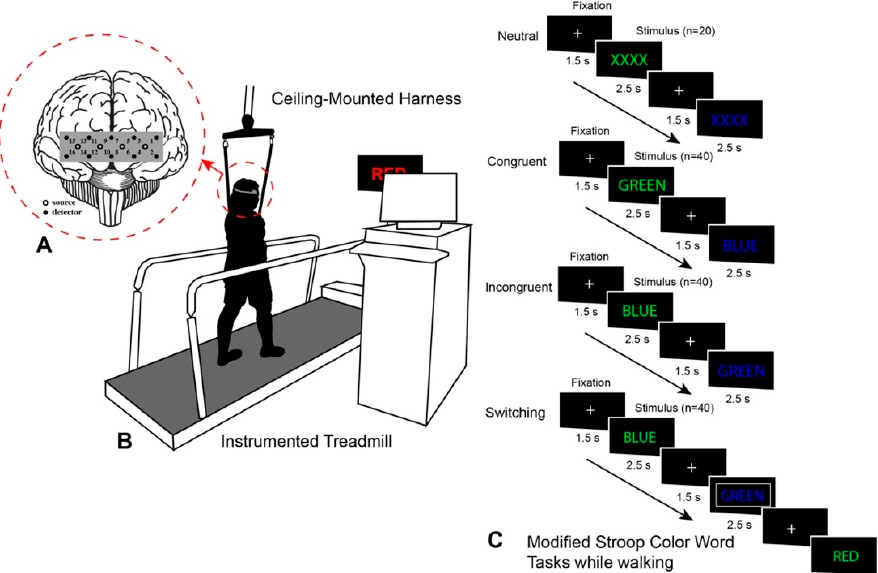
Figure 2. Schematic of experimental setup with fNIRS headband ( A ), instrumented treadmill and monitor with visual cues ( B ), and cues during MSCWT neutral, congruent, incongruent, and switching tasks ( C ). Note: MSCWT = Modified Stroop Color Word Test.